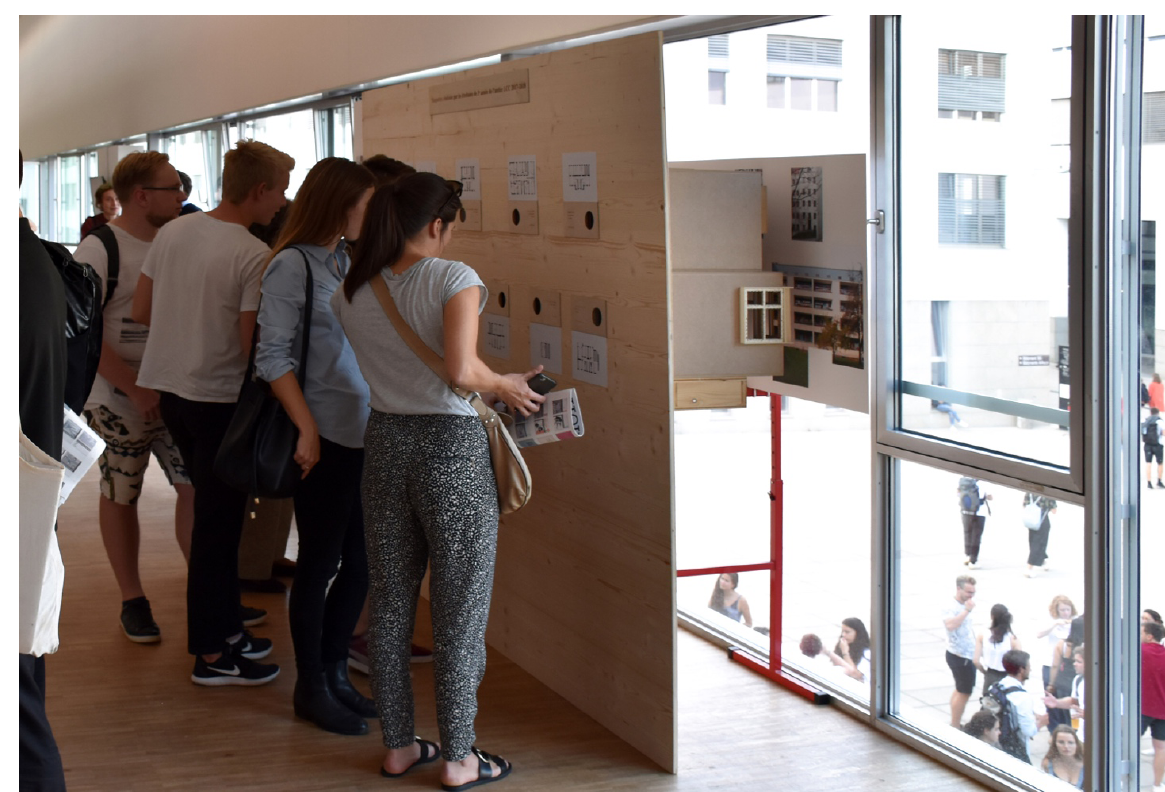
Figure 12. Participants to the opening who curiously watch into the one-room scale models. Source: Authors.